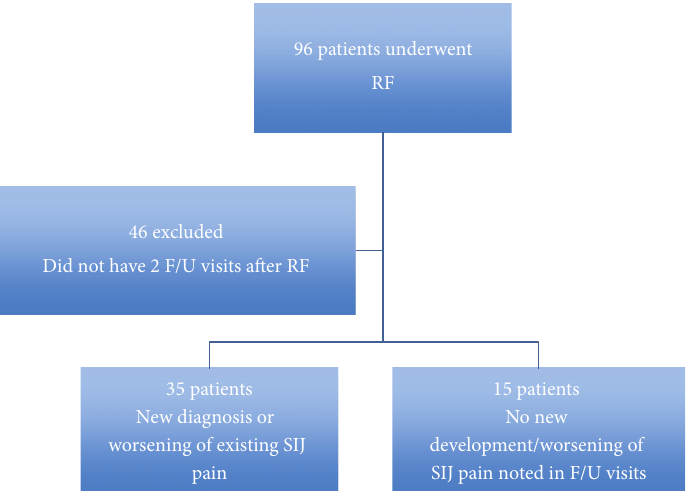
Figure 1: Study results depicting new development of Sacroiliac pain after Lumbar Radiofrequency rhizotomy. SIJ, Sacroiliac joint; RF, radiofrequency (lumbar)